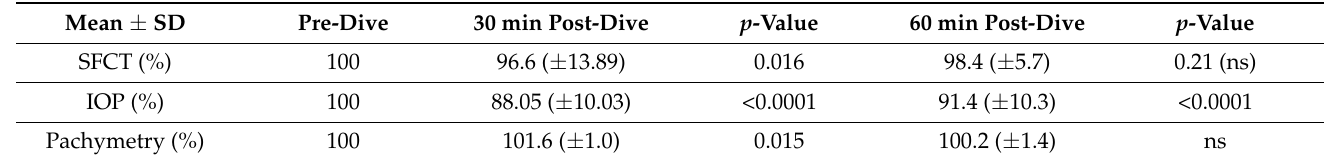
Table 1. Comparison (in percentage of pre-dive values) of SFCT, IOP, and pachymetry between pre- and post-dive values at 30 min and 60 min post dive.